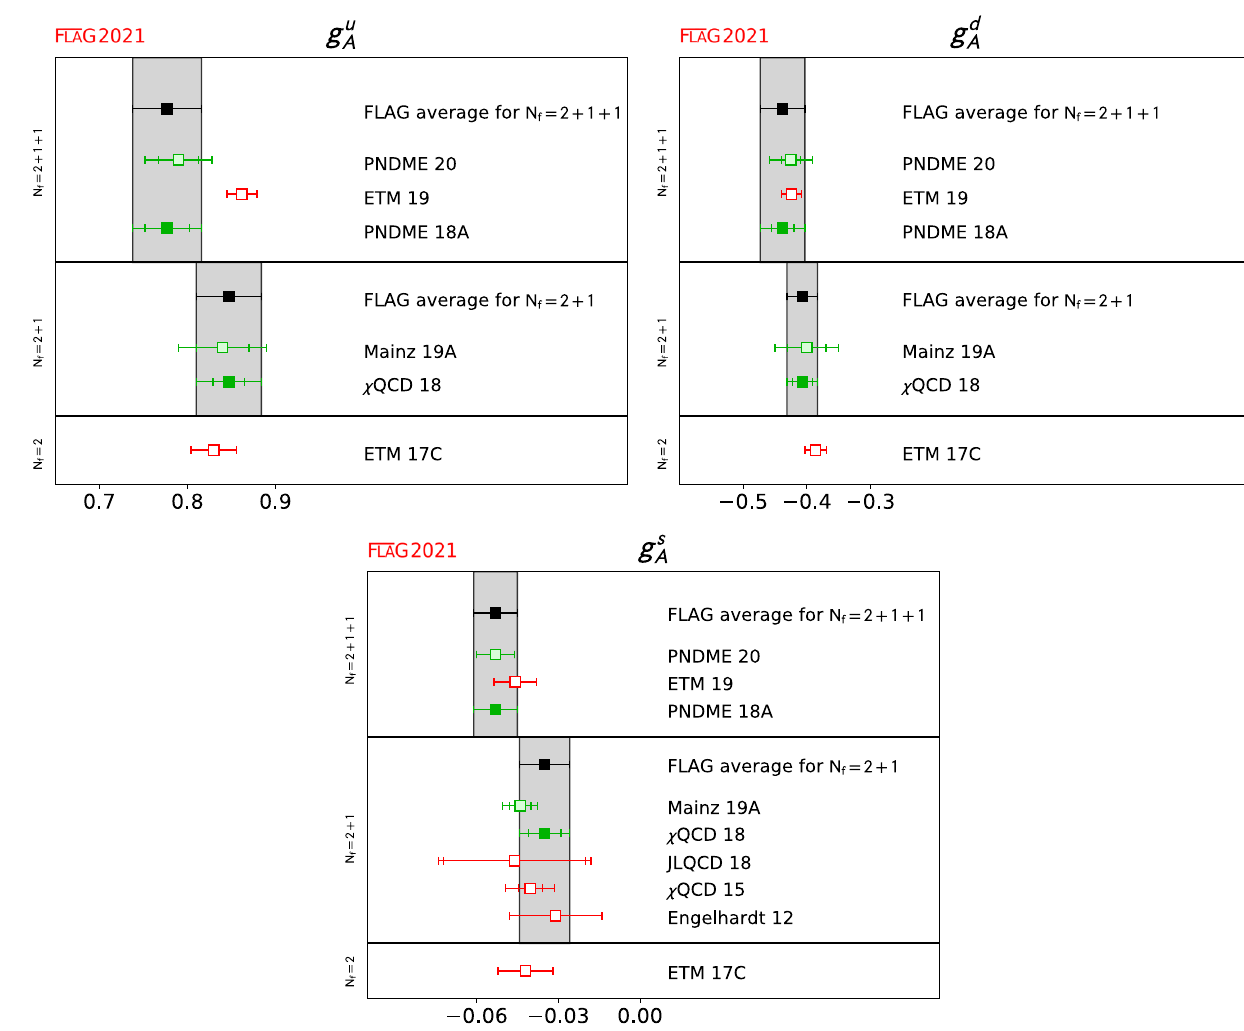
Fig. 46 Lattice results and FLAG averages for g u , d , s